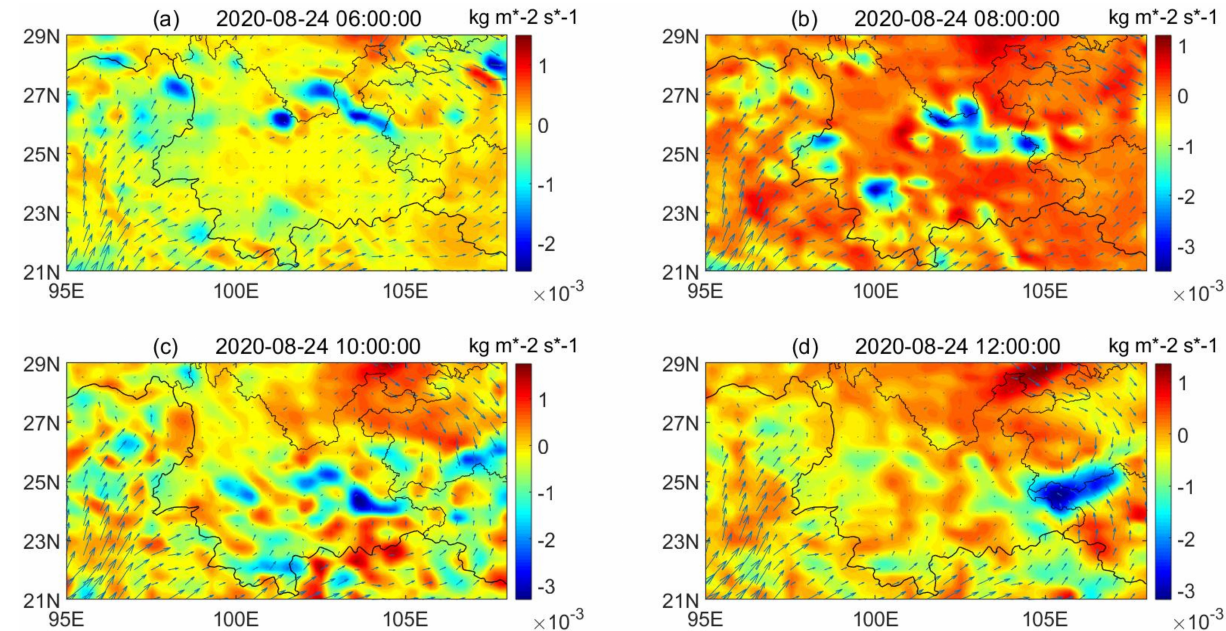
Figure 7. The combination of ∇ p and 850 hPa wind field in Yunnan–Guizhou Plateau from 06:00 (UTC) to 12:00 on 24 August 2020 (the isosurface represents the ∇ p , unit: kg m − 2 s − 1 . The direction of the arrow represents the wind direction, and the length represents the wind speed. ( a – d ) represent the results of 2 h